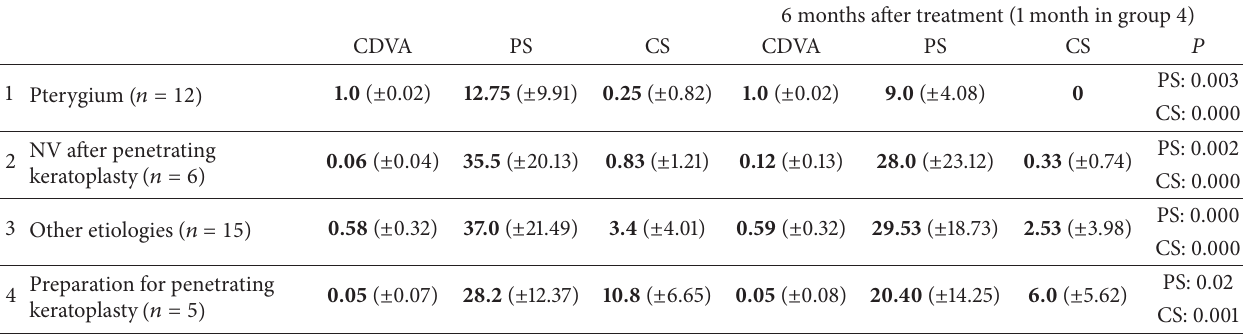
Table 3: Results of separate subgroups of group B before and six months after initiation of treatment; mean number of affected peripheral (PS) and central segments (CS) of neovascularization; corrected distance visual acuity